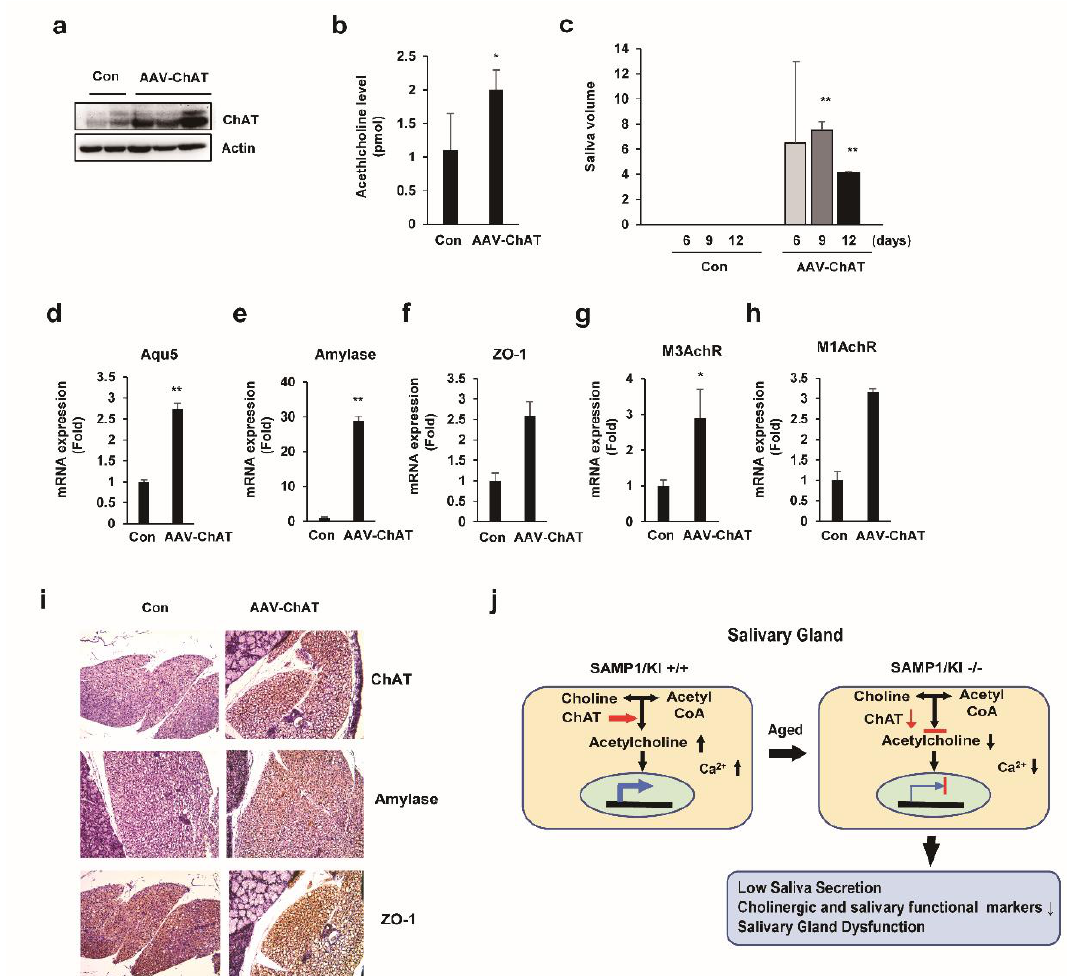
Figure 6. Regeneration of salivary gland function in SAMP1/kl -/- mice by adeno-associated virus (AAV)-ChAT delivery. SAMP1/kl -/- mice were either treated with phosphate-buffered saline (PBS, negative control) or AAV-ChAT at 6 weeks of age. Each mouse was injected with 2 × 10 10 GCs of AAV-ChAT in 20 μL of PBS via intraglandular injection. Unstimulated saliva was collected every 3 days post injection. After 12 days, the mice were sacrificed, and the salivary glands were harvested for analysis. ( A ) Western blotting was conducted to confirm the expression of ChAT in the salivary glands. ( B ) The acetylcholine concentration was measured in the control and injected salivary glands. ( C ) Comparison of the secreted saliva volume between the control and injected group every 3 days. ( D – H ) Comparison of cholinergic signaling-related gene and functional marker expression in salivary gland tissues. ( I ) Immunohistochemistry analysis of the paraffin-embedded salivary glands derived from SAMP1/kl -/- and SAMP1/kl -/- mice injected with AAV-ChAT. ( J ) Summary of metabolic alterations in salivary gland of SAMP1/kl +/+ and SAMP1/kl -/- mice. Data are presented as the mean ± SD. * p < 0.05, ** p < 0.01.